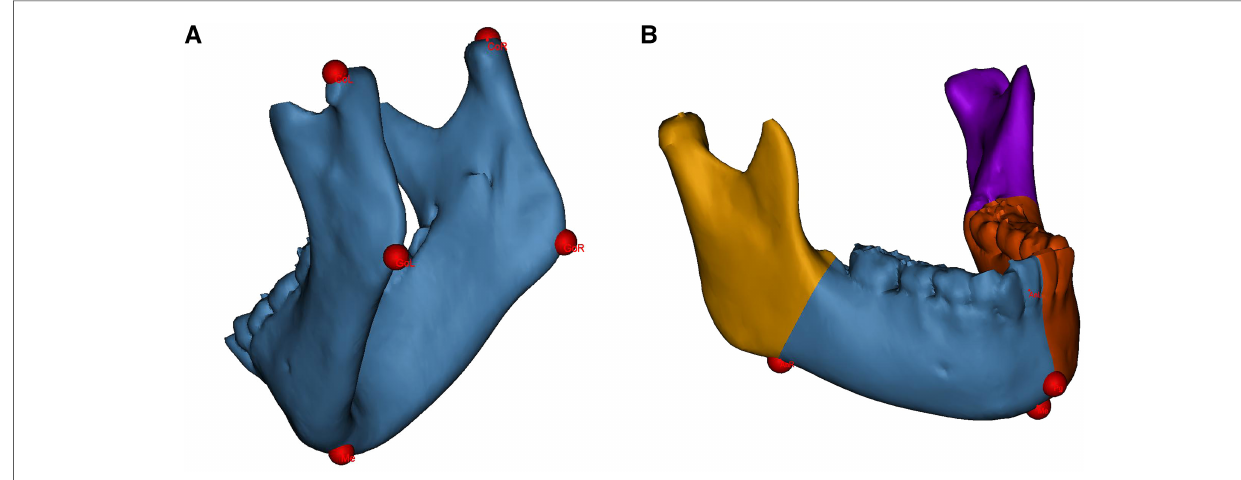
FIGURE 1 Landmarks identi fi cation and mandibular segmentation on the 3D model. ( A ) landmarks for linear measurements. ( B ) The mandible is divided into the proximal segments and the dentate segments for volumetric measurements. CoL, condylion left; CoR, condylion right; GoL, gonion left; GoR, gonion right; Me, menton; Pg, pogonion; AnL, antegonial notch left; AnR, antegonial notch